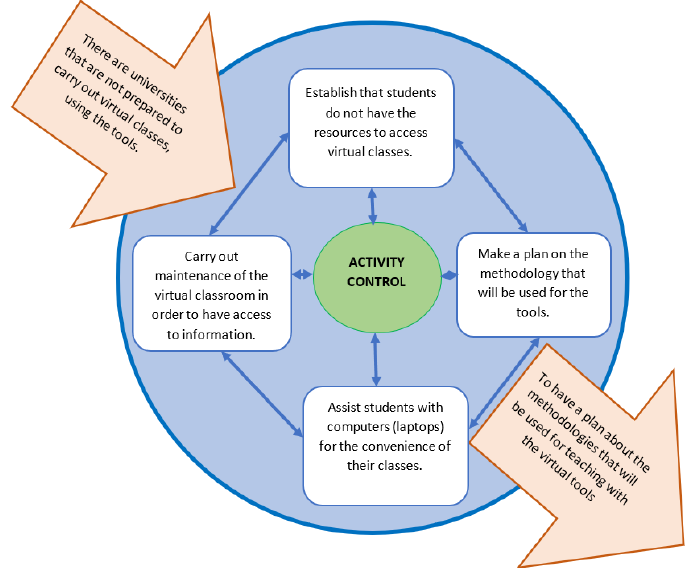
Fig. 13. Conceptual model applied to universities